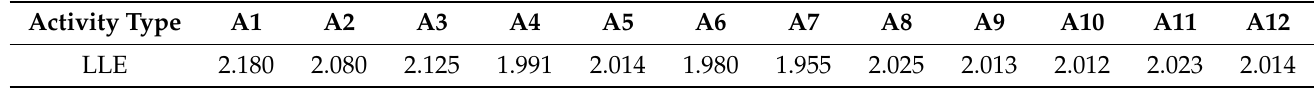
Table 2. The largest Lyapunov exponent (LLE) of all activities.